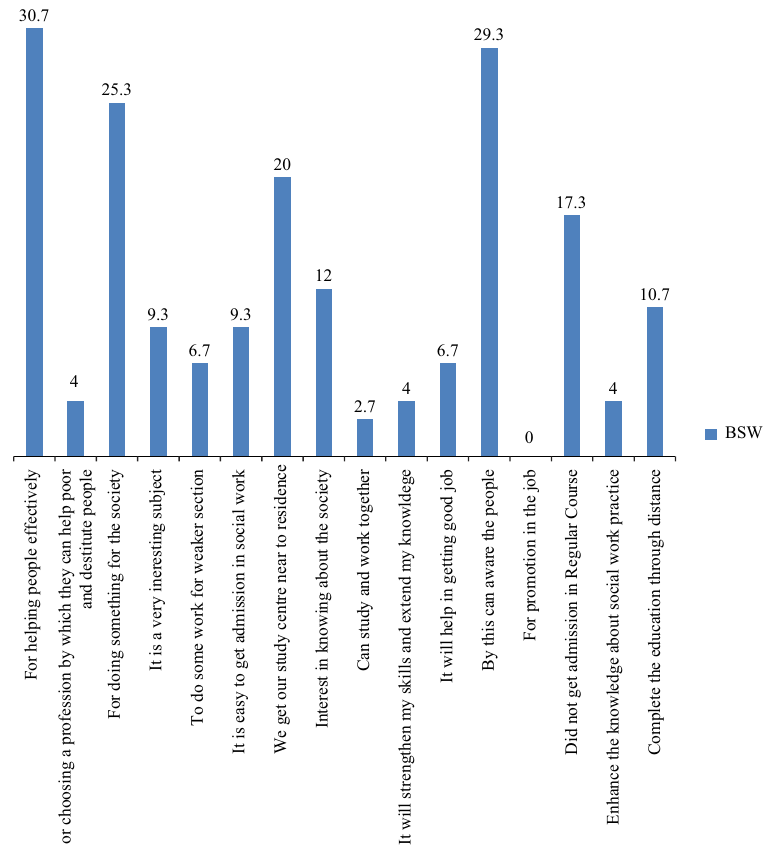
Figure 1. Reasons for